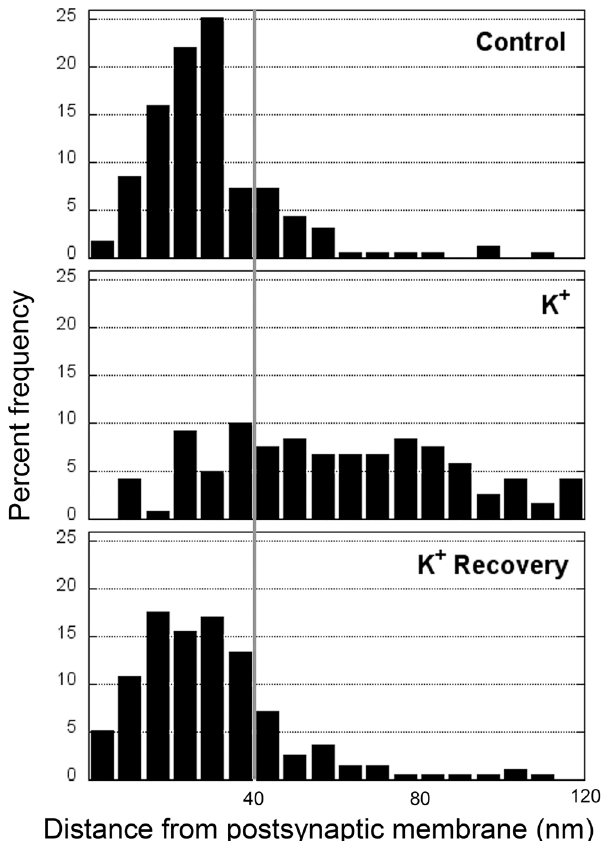
Fig 3. The distribution of AIDA-1 at the PSD complex is regulated by activity. Histograms from a representative experiment depicting the distribution of AIDA-1 label, within an area extending 120 nm deep from the postsynaptic membrane. Distances of gold particles (AIDA-1 label) from the postsynaptic membrane were measured in control samples, in depolarized samples (K + ) and in samples were let to recover for 30 min in control medium after depolarization (K + recovery). The vertical line depicts assigned threshold separating the PSD core from the contiguous zone (PSD pallium).